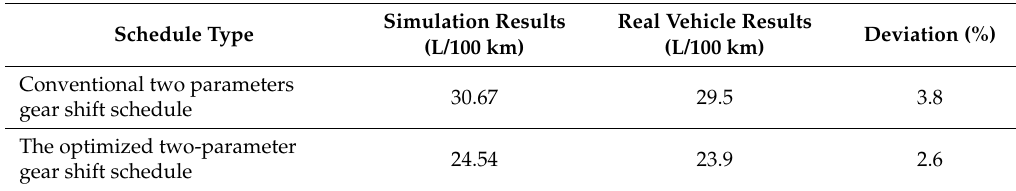
Table 3. Fuel consumption in simulation and real vehicle